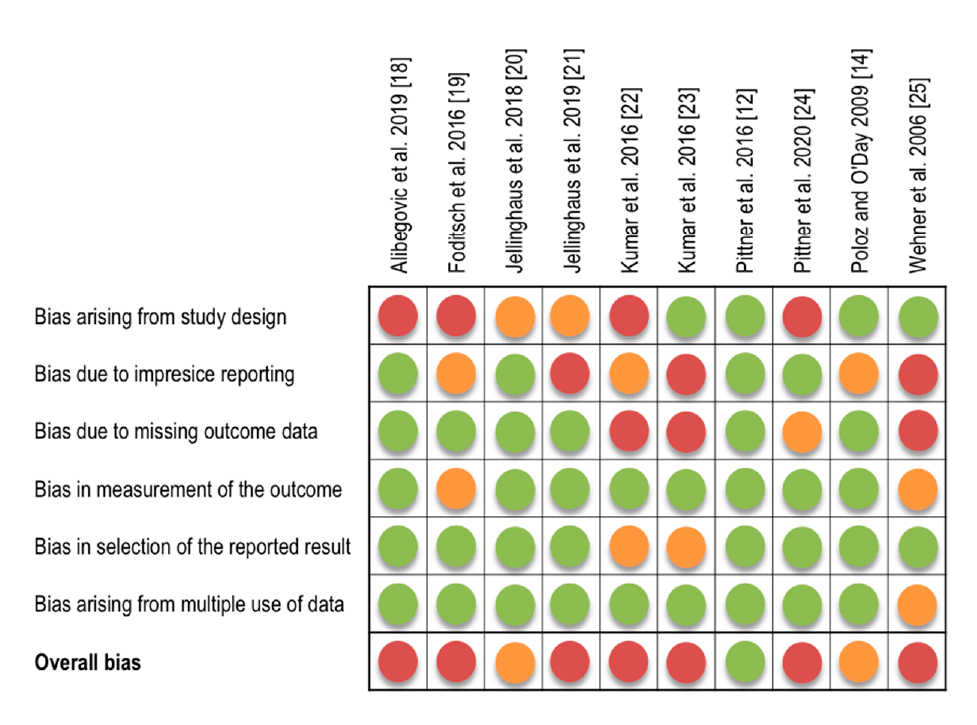
Figure 3. Risk of bias assessment of included studies. Green, low risk of bias; yellow, moderate risk of bias; red, high risk of